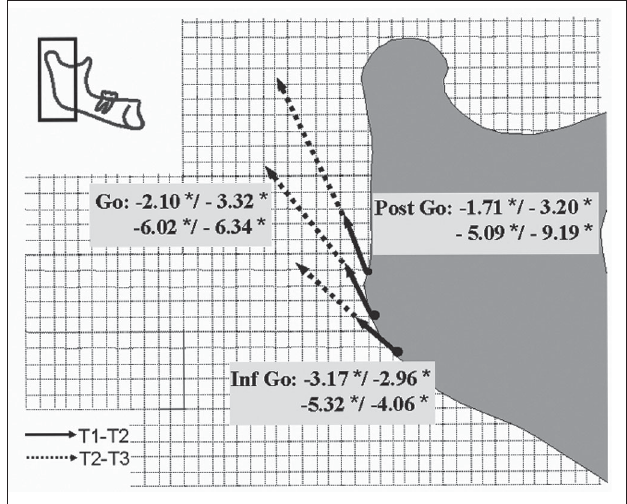
Fig. 5 . Remodeling of the gonial angle between T1 and T2 (upper data) and between T2 and T3 (lower data). Horizontal/vertical components are proportional in scale. Each square represents 1 mm.